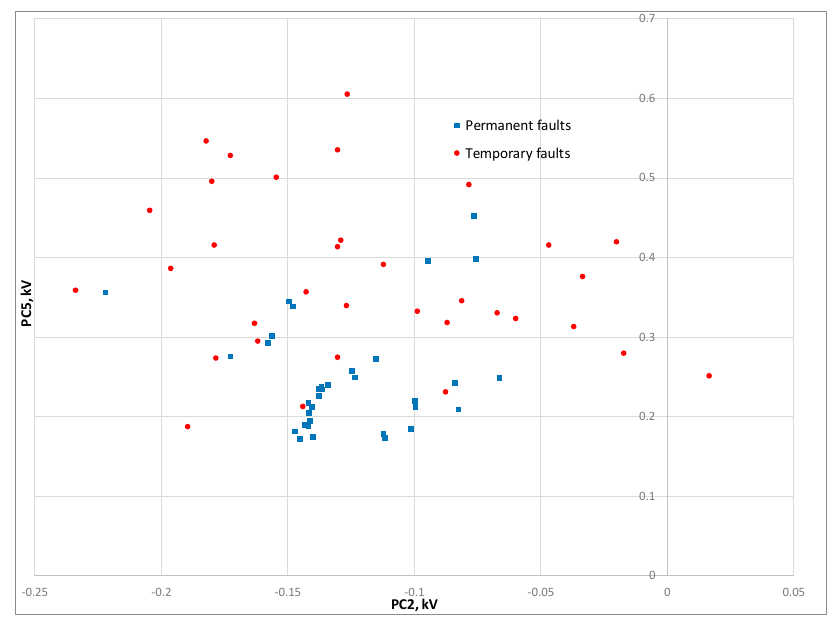
Figure 7. Permanent and temporary faults in the first and third subspace of PCs.